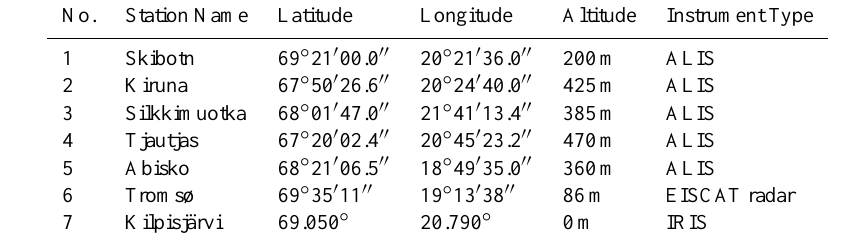
Table 1. Coordinates of stations used in this paper.